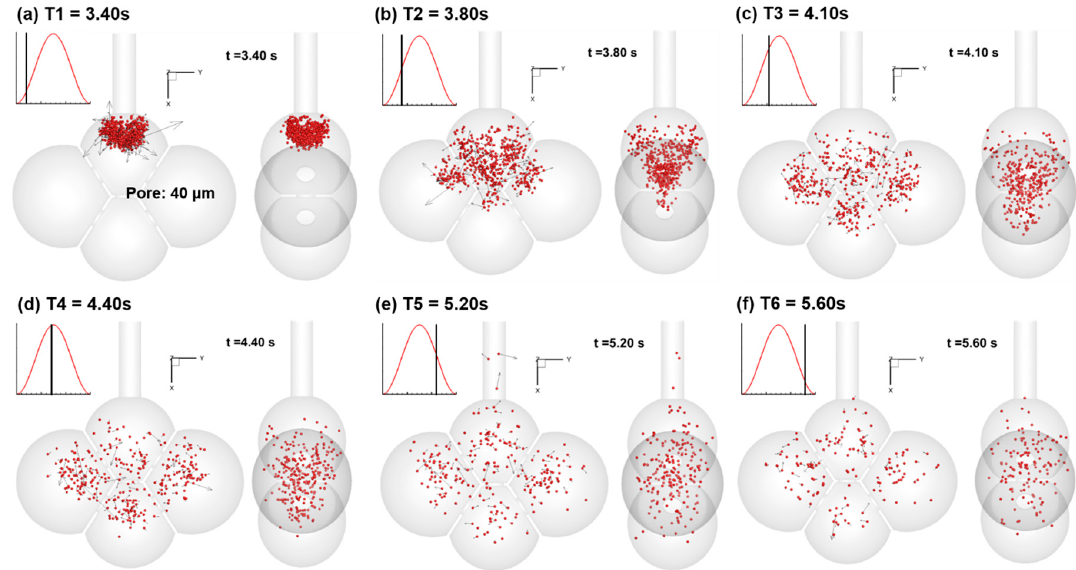
Figure 5. snapshots of particle positions in the 40-µm-pore alveolar model during the first cycle at different instants: ( a ) T1 = 3.40 s, ( b ) T2 = 3.80 s, ( c ) T3 = 4.10 s, ( d ) T4 = 4.40 s, ( e ) T5 = 5.20 s, and ( f ) T6 = 5.60 s. Particles were 200 nm in diameter and were released 0.2 s (T0 = 3.20 s) from the second breathing cycle. The first cycle (0–3 s) was simulated to establish the transient airflow field. Due to particle Brownian motion and convection, some particles exited the geometry during exhalation.